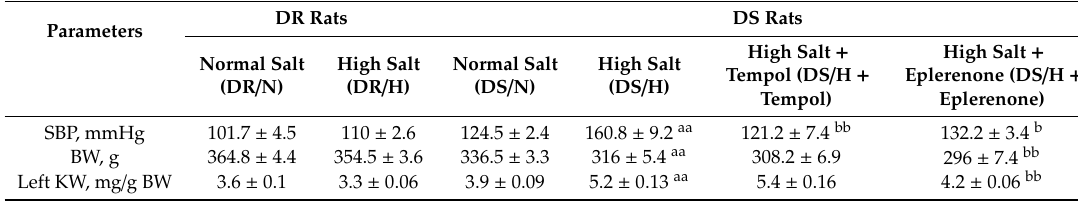
Table 1. Parameters at four weeks after the procedures in DR and DS